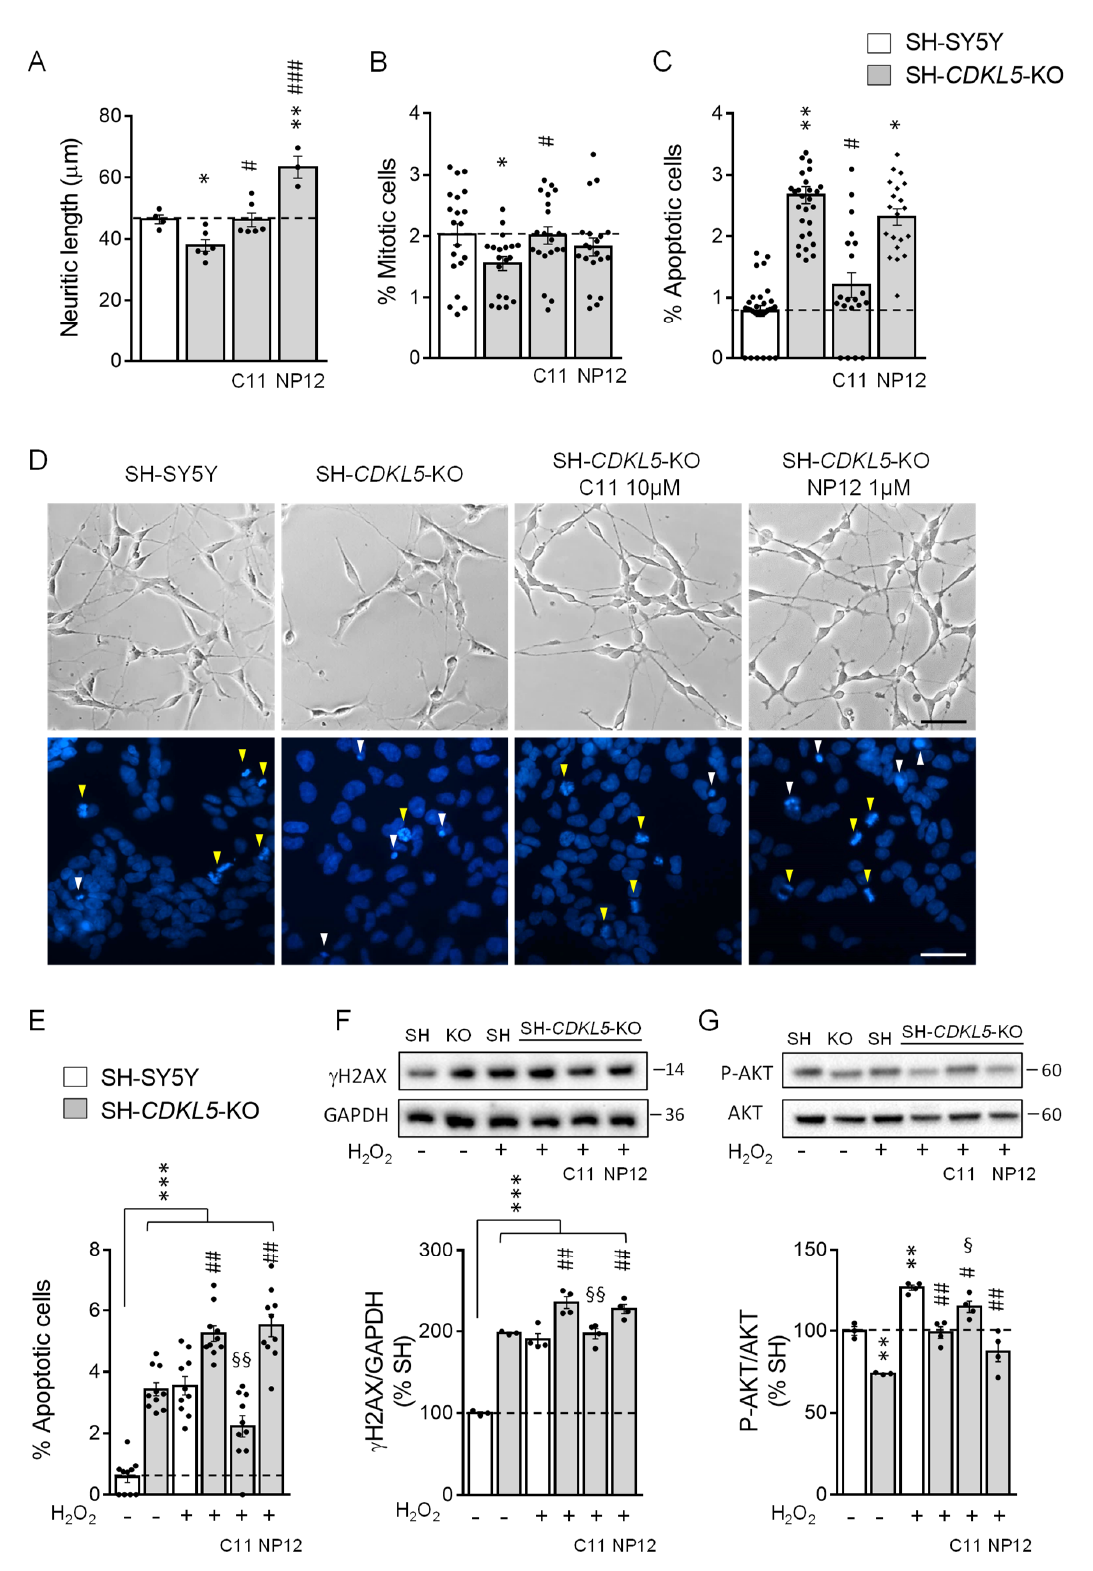
Figure 2. Effect of treatment with C11 on cell differentiation, proliferation, and survival in SH- CDKL5 -KO cells. ( A ) Quantification of neurite outgrowth of SH-SY5Y ( n = 4) and SH- CDKL5 -KO ( n = 6) cells treated daily with retinoic acid (RA; 10 μ M) for 5 days. SH- CDKL5 -KO cells were treated with C11 (10 μ M, n = 6) or NP12 (1 μ M, n = 6) every 2 days during retinoic acid differentiation. ( B , C ) Percentage of mitotic ( B ) and apoptotic ( C ) cells in proliferating SH-SY5Y ( n =